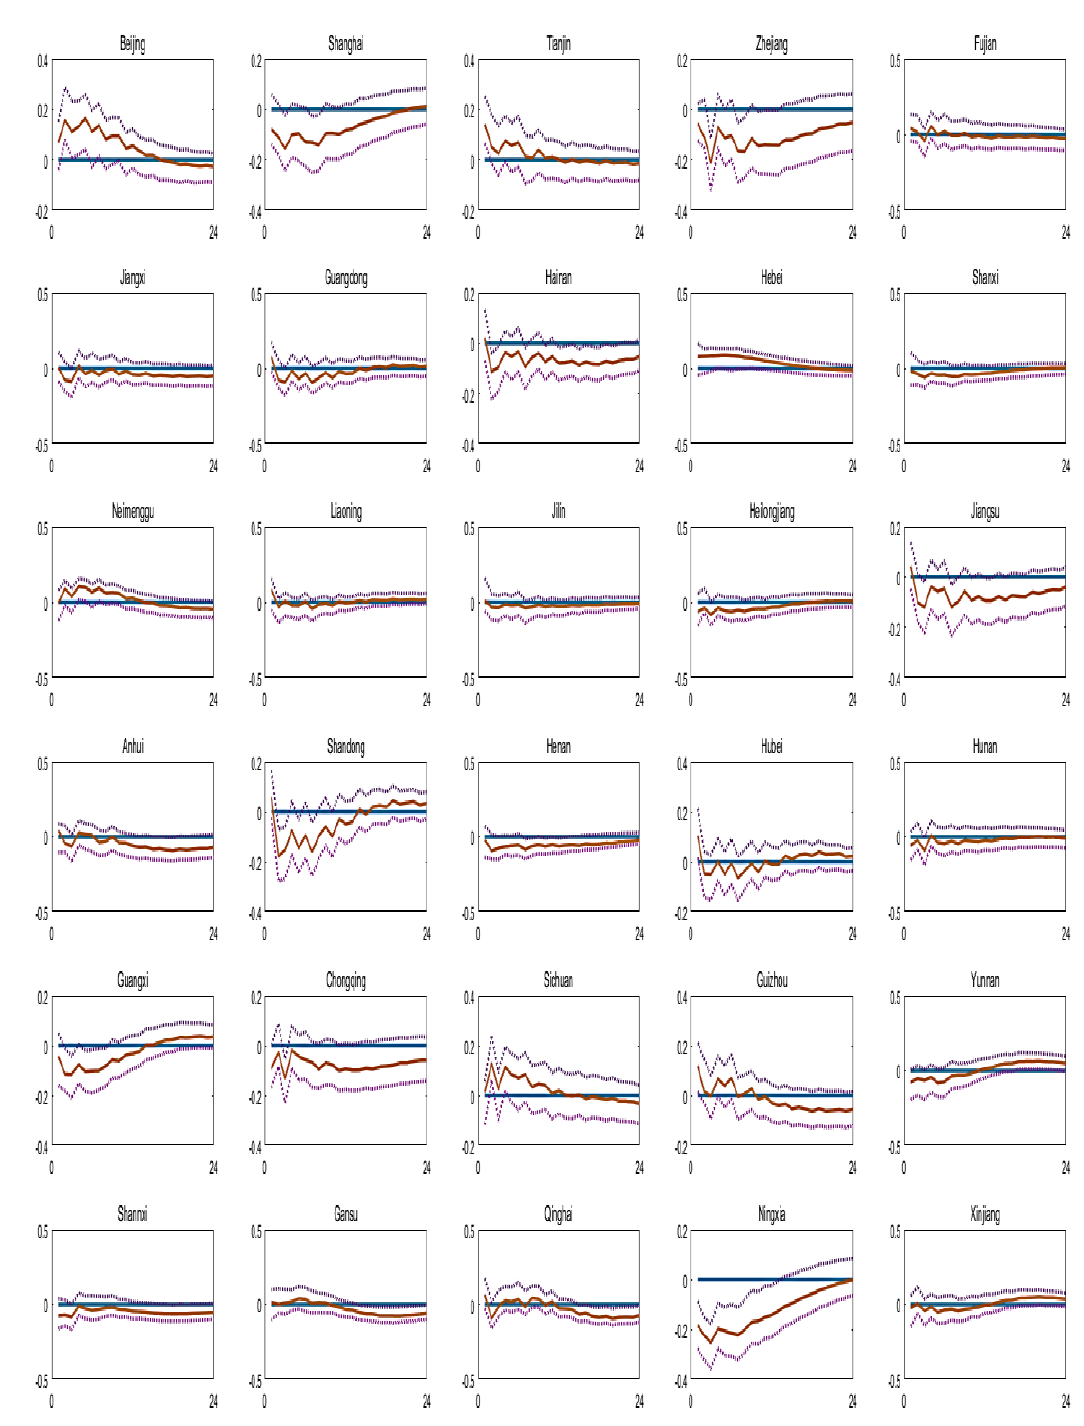
Figure A4. Impulse responses of regional house prices to one standard error shock to inflation rate: FAVAR system with three factors.